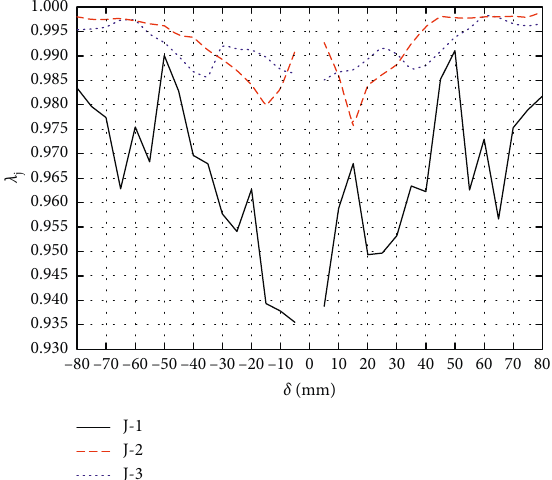
Figure 15: Comparison of the capacity degeneration coefficient.